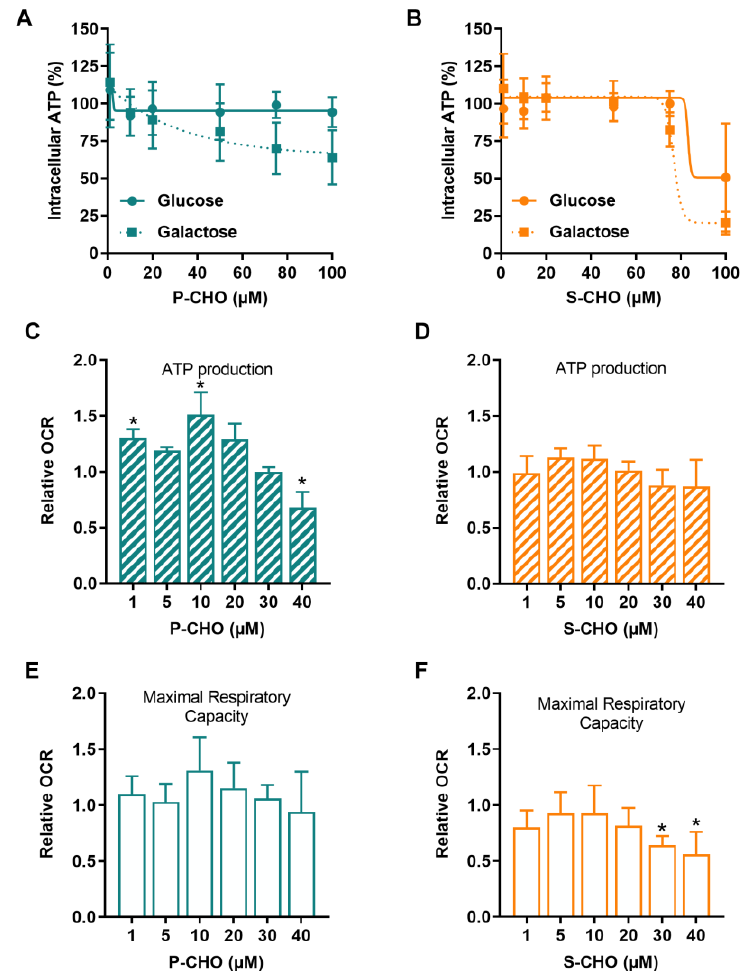
Figure 4. Pazopanib and sunitinib aldehydes impair mitochondrial function. Mitochondrial function was assessed in HepG2 cells by detecting intracellular ATP in cells cultured in a glucose (solid line) or a galactose (dotted line) medium and exposed to increasing concentrations of P-CHO ( A ) or S-CHO ( B ). Relative oxygen consumption rate (OCR) was measured by Seahorse assay in HepG2 cells cultured in a glucose medium. ATP production and Maximal Respiratory Capacity were evaluated for P-CHO ( C , E ) and S-CHO ( D , F ) and were expressed as the fold-change of OCR measured in non-treated cells. * p value < 0.05 compared to non-treated cells.